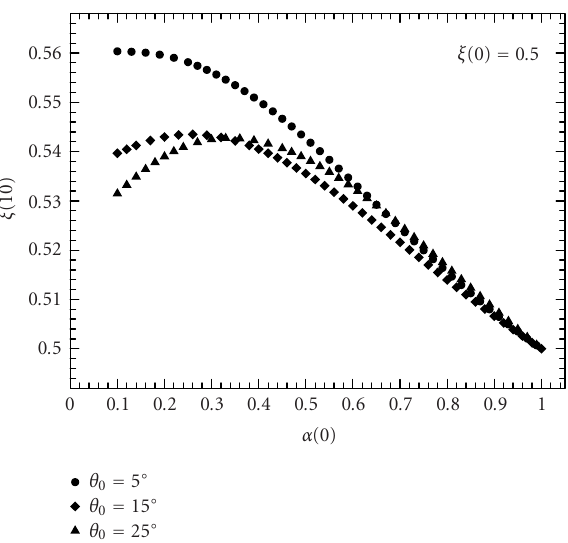
Figure 9: The vertical distorted velocity coe ffi cient β propagates along axial direction at higher inlet incident angles, θ 0 ≥ 25 ◦ .